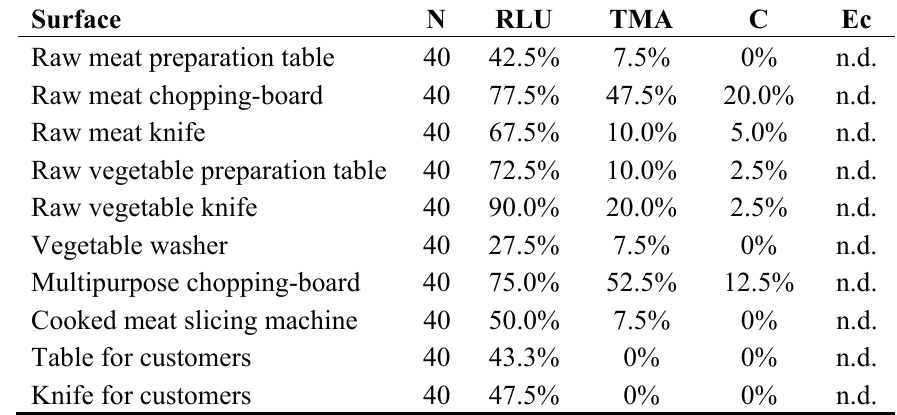
Table 2. Frequency of non-conforming samples based on RLU and bacterial viable counts (TMA, C and Ec) after routine cleaning and sanitation of food contact